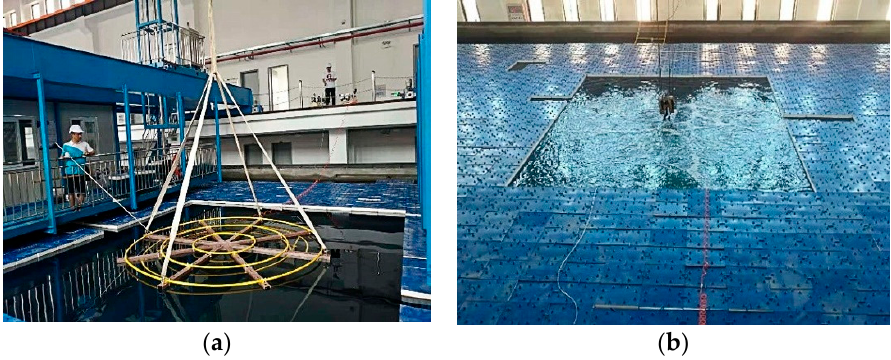
Figure 6. Gas injection frame layout. ( a ) Gas injection frame ; ( b ) Artificial upwelling.